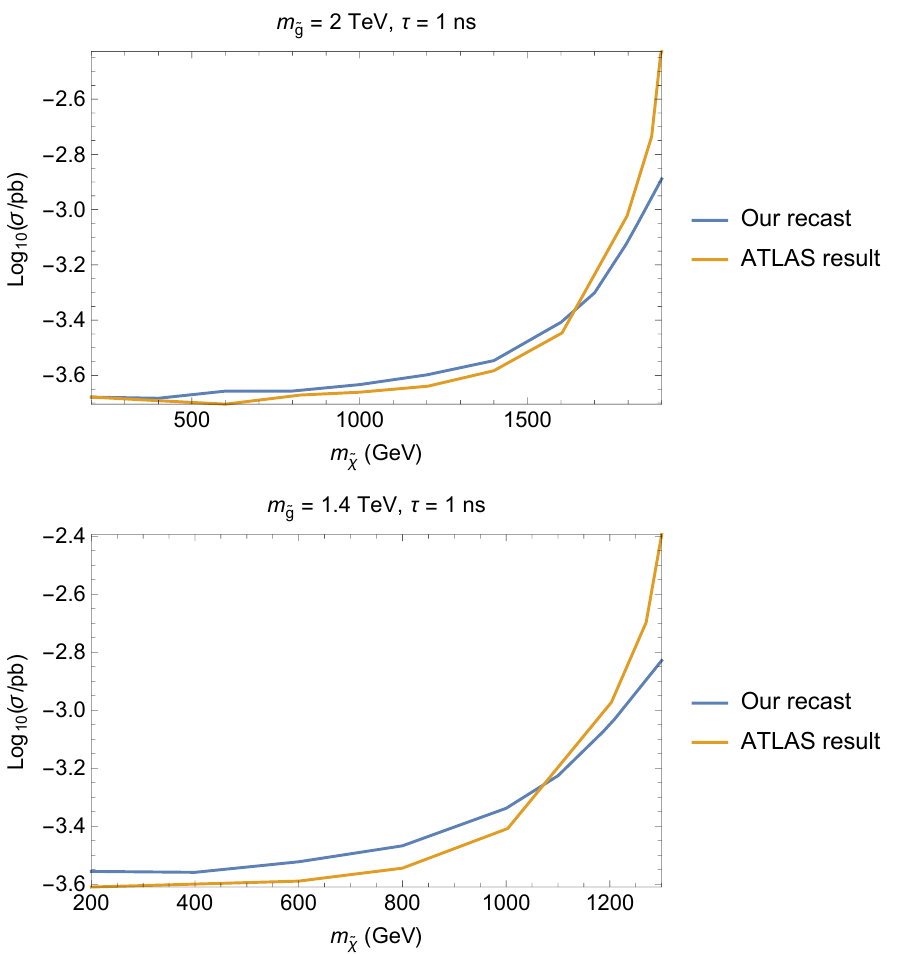
Figure 14 . Excluded cross sections at 95% C.L. as a function of the neutralino mass, for a long lived gluino decaying to a quark pair and a neutralino, compared to the published result from ATLAS [45]. The gluino mass is (cid:12)xed to 2 TeV (top) or 1.4 TeV (bottom). The gluino lifetime is (cid:12)xed to 1